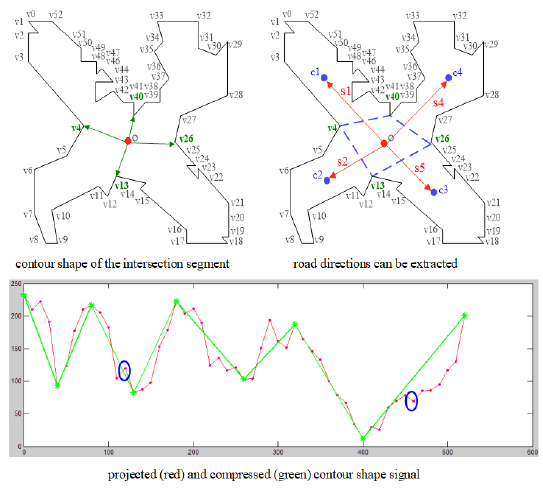
Figure 1. Illustration of road intersection recognition